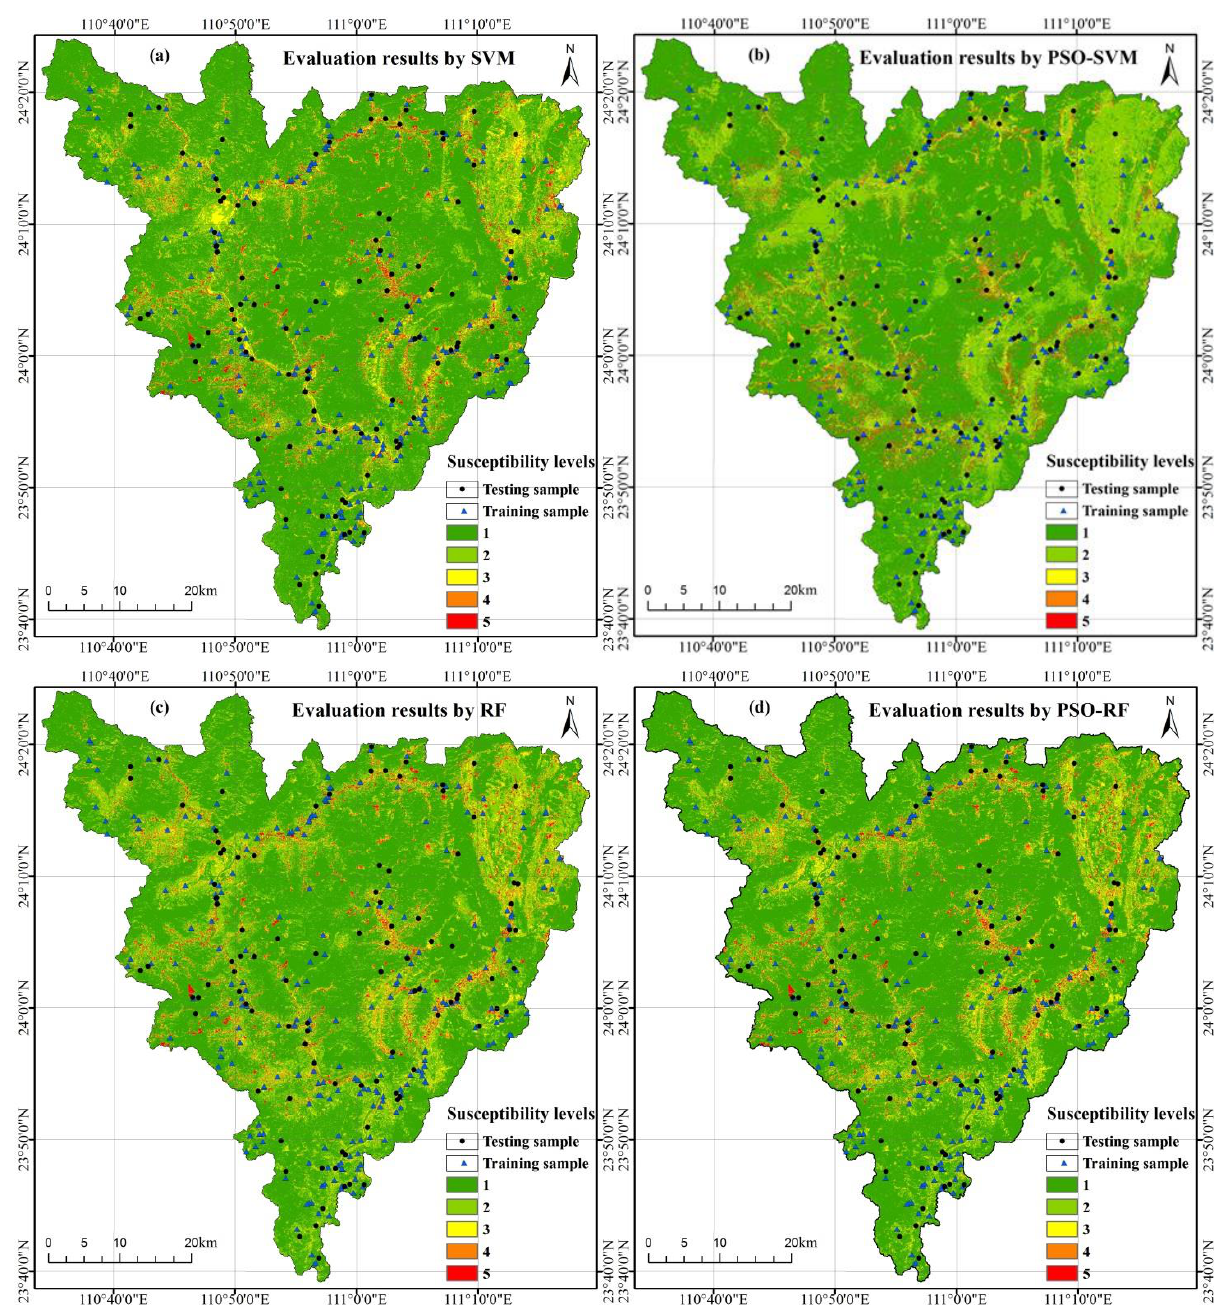
Figure 6. Landslide susceptibility overlying maps of field survey and evaluation results for four ML models in Zhaoping (1-extremely low, 2-low, 3-medium, 4-high, 5-extremely high; ( a ) SVM, ( b ) PSO-SVM, ( c ) RF, ( d ) PSO-RF). Figure 6 indicates that the landslide susceptibility evaluation results of four ML models in Zhaoping are in accordance with the distribution of landslide